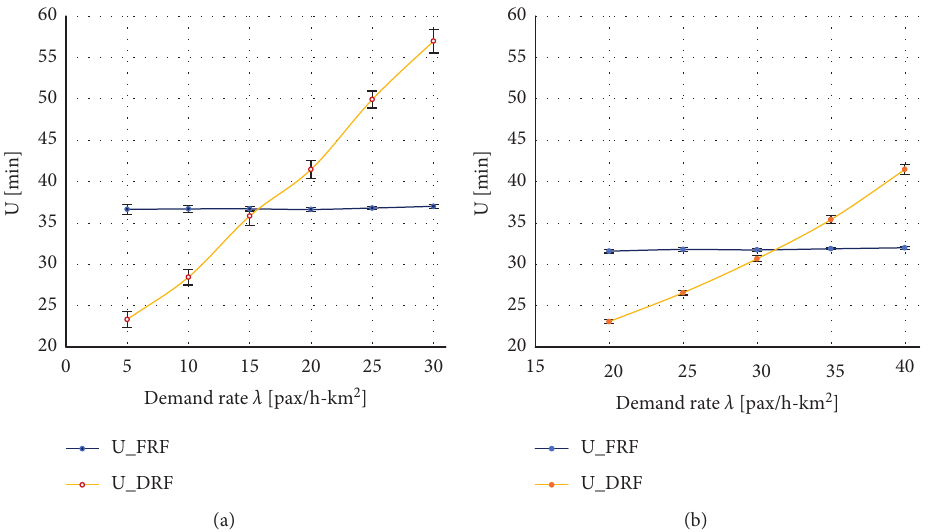
Figure 6: Disutility of Sc-A1 (a) and Sc-A2 (b) (bars showing confidence